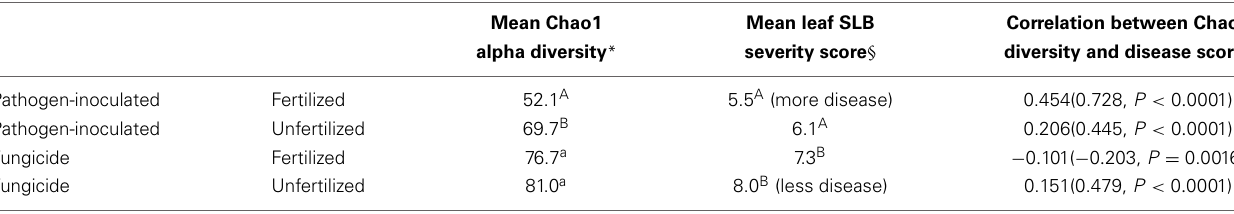
Table 1 | Microbial diversity and disease